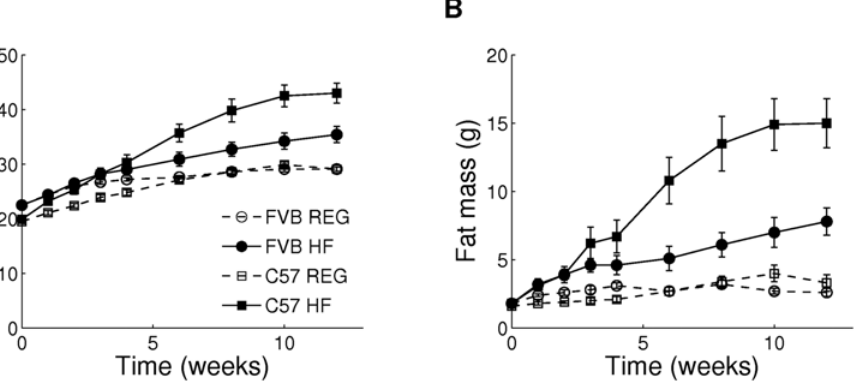
Figure 1. Changes in body composition of FVB and C57 mice under standard chow (REG) and high-fat (HF) conditions. (A) Body weight. (B) Fat mass. Body composition was measured at indicated time points in 8 mice per group using Echo 3-in-1 MRI analyzer. High-fat and control feeding were initiated at the age of 5 weeks. X-axis indicates weeks of controlled feeding. One of three independent experiments is shown. Values given are mean 6 SEM.